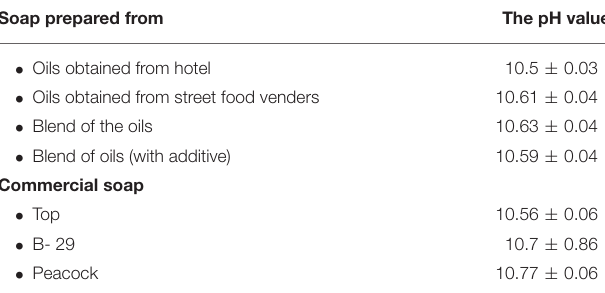
TABLE 5 | The pH values of prepared and commercial soap